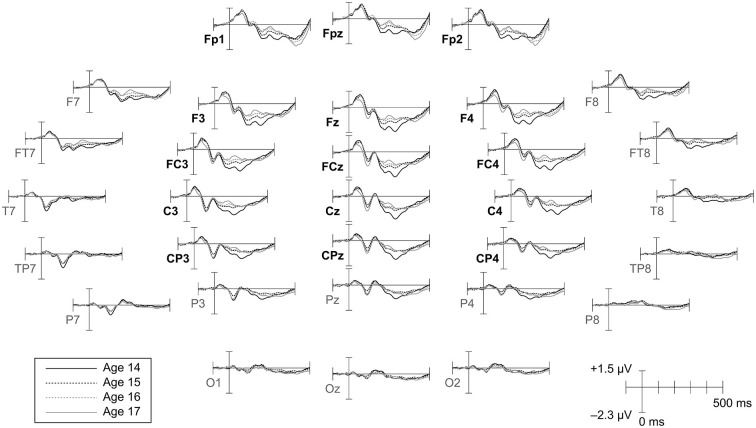
Topographic distribution of CAEPs by age. Grand average waveforms for each age are shown at all electrodes. Ages 14 and 17 are plotted as solid lines to highlight changes across the duration of the study. Electrodes included in the frontrocentral region of interest (ROI) employed for amplitude and variability analyses are labeled in bold.